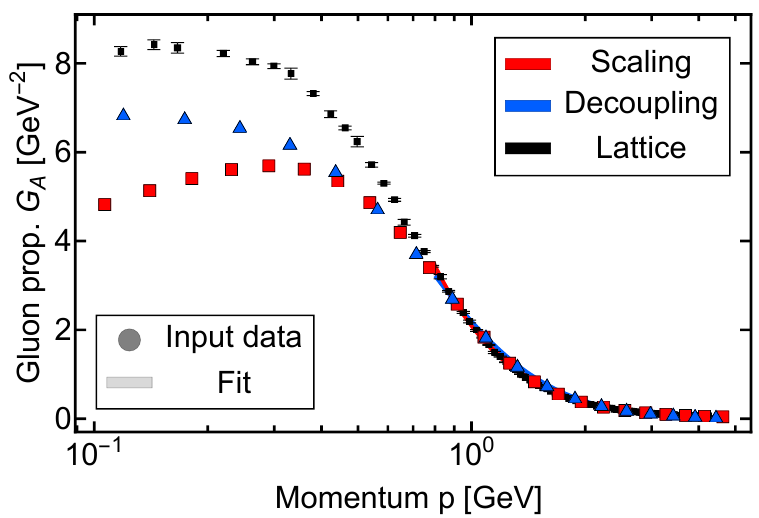
Figure 4: Gluon propagators from the fRG [ 47 ] in the scaling (red) and decoupling (blue) scenario as well as lattice data from [ 22 ] with a continuum and infinite volume extrapolation, see [ 84,85 ] . Coloured / black markers show the data. Solid lines show the respective fits from which the wave function renormalisation Z computed. The fit Ansätze are given in eq. (95). Here, we plot fits to the propagator data over the maximal fit interval, see also Appendix E for